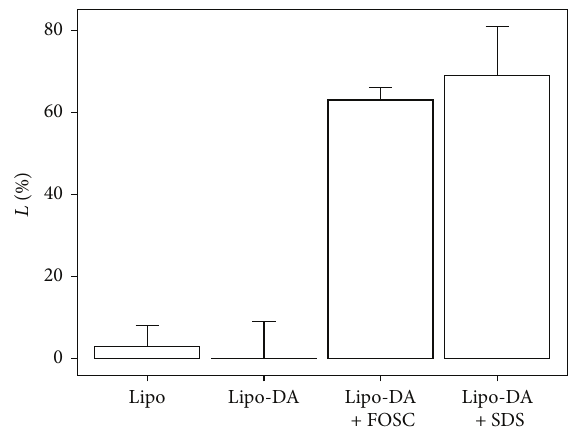
Figure 6: Relative changes in fluorescence intensity ( 𝐿 %) of mul- tilamellar liposomes and reconstituted DA-liposomes (Lipo-DA) challenged with SDS (5mmol/L) and FOSC at 7.5